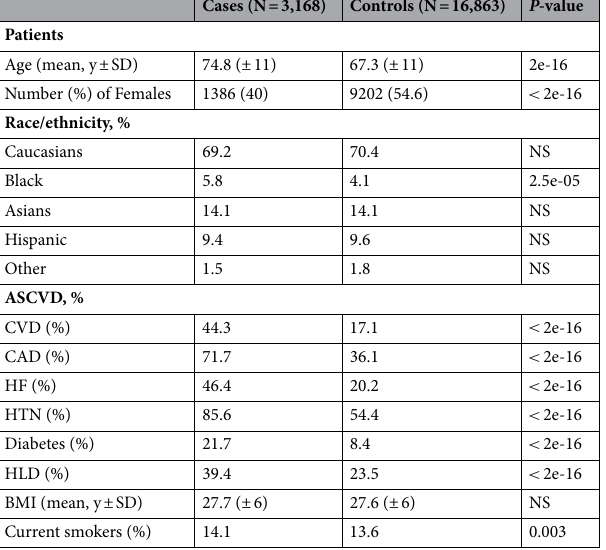
Table 1. Descriptive statistics of case and control cohorts. ASCVD—Atherosclerotic cardiovascular disease; CVD—cerebrovascular disease; CAD—coronary artery disease; HF—heart failure; HTN—hypertension; HLD—hyperlipidemia; BMI—body mass index.